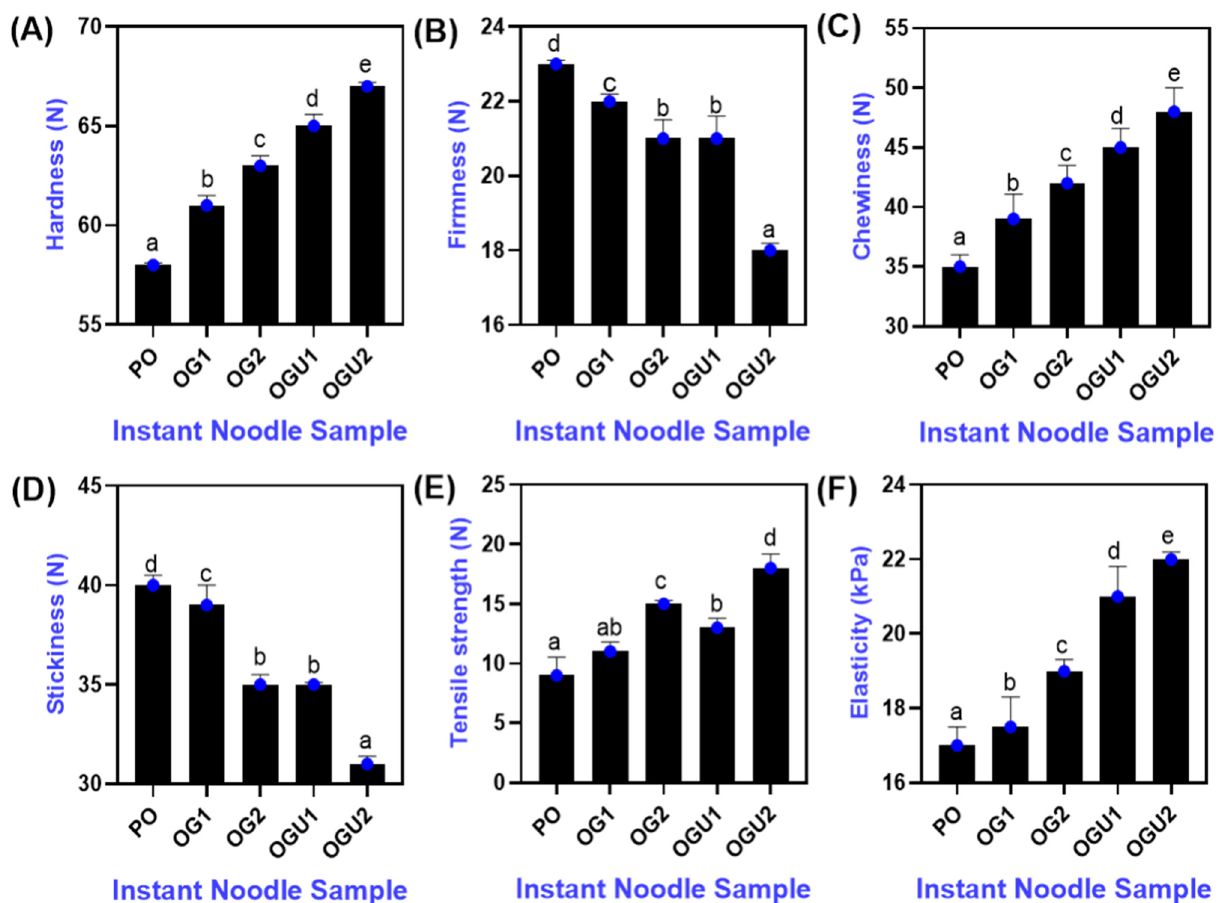
Figure 3. Textural profile (hardness ( A ), firmness ( B ), chewiness ( C ), stickiness ( D ), tensile strength ( E ) and elasticity ( F )) of palm oil, palm oil–carnauba wax oleogel and palm oil–carnauba wax oleogel with ultrasonication treatments. Note: PO represents palm oil; OG1 represents palm oil–carnauba wax (5 g/100 g); OG2 represents palm oil–carnauba wax (10 g/100 g); OGU1 represents palm oil–carnauba wax (5 g/100 g) homogenized with ultrasonication; and OGU2 represents palm oil–carnauba wax (10 g/100 g) homogenized with ultrasonication. The different alphabets (a–e, ab) in the figures indicate significant differences.